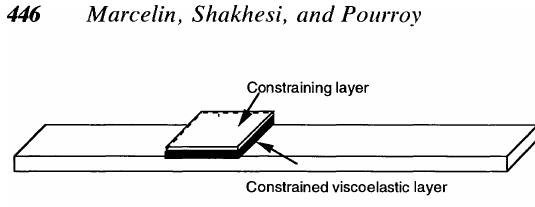
FIGURE 1 Beam damped by viscoelastic